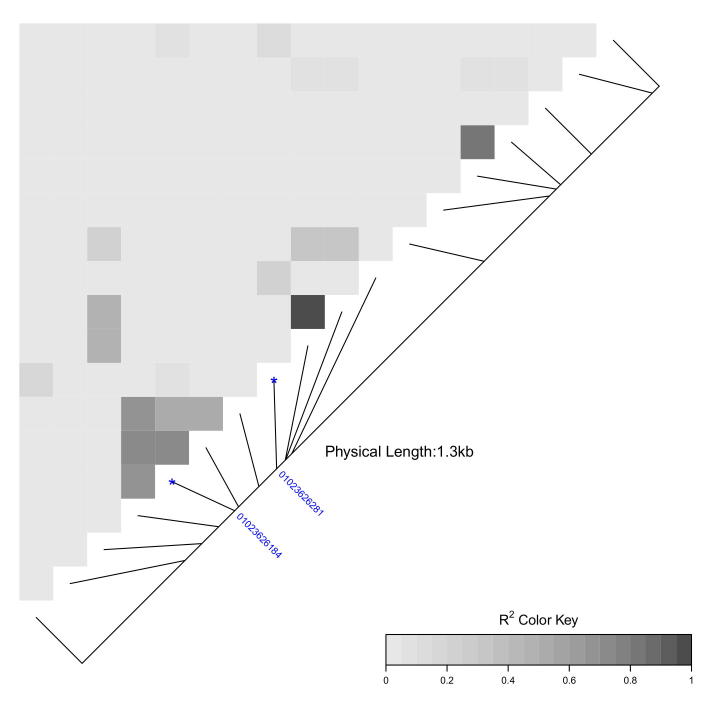
Linkage disequilibrium between SNPs in the genomic region of the gene gt1 displayed as a heat map.